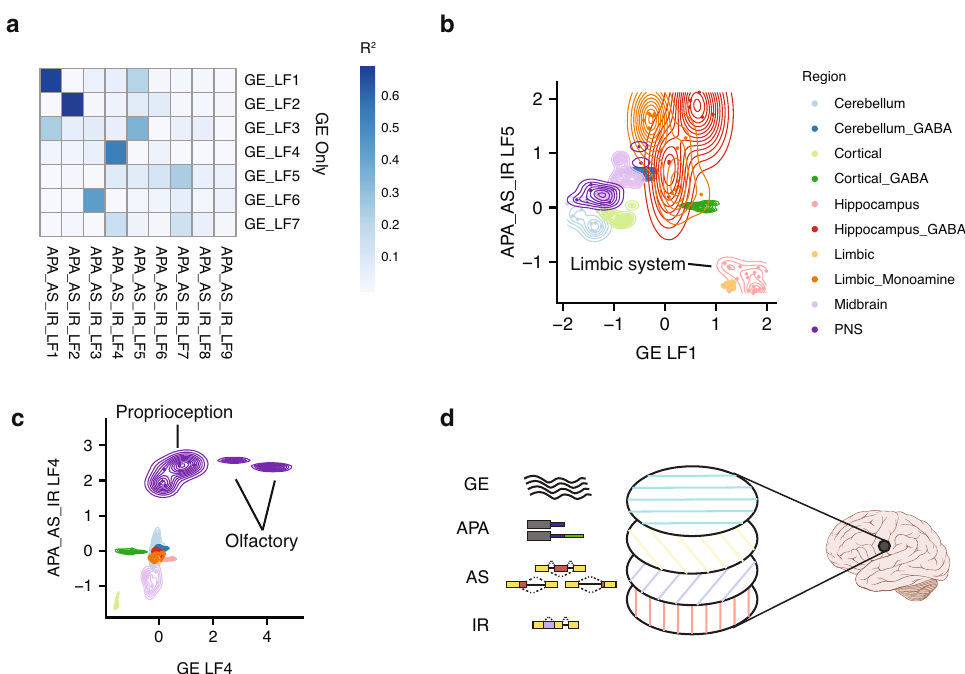
Fig. 5 Variable contributions of transcriptomic regulatory layers to the de fi nition of neuronal identity. a Heatmap showing the Pearson correlation ( R 2 ) between pairs of latent factor weights assigned to each sample inferred when only GE data is analyzed ( y -axis) and when only APA_AS_IR data are analyzed ( x -axis). Latent factors that are highly correlated indicate neuronal population groupings identi fi ed by GE data only, and independently by APA_AS_IR data. b Combined scatter and contour plot comparing the latent factor weights between GE-LF1 and APA_AS_IR-LF5. Both factors identify a cluster of hippocampal neurons. However, each factor distinguishes the neurons differently (see Fig. 4c for description of contour plots). c Comparison between GE-LF4 and APA_AS_IR-LF4. Both factors identify a cluster of peripheral nervous system (PNS) neurons. However, GE-LF4 speci fi cally identi fi es a subset of PNS neurons belonging to the olfactory system. d Multiple “ layers ” of coordinated transcriptomic regulatory networks collectively and differentially contribute to establishing neuronal identity throughout the nervous system. Brain schematic by Patrick Lynch 78 , distributed under a Cresative Commons Attribution